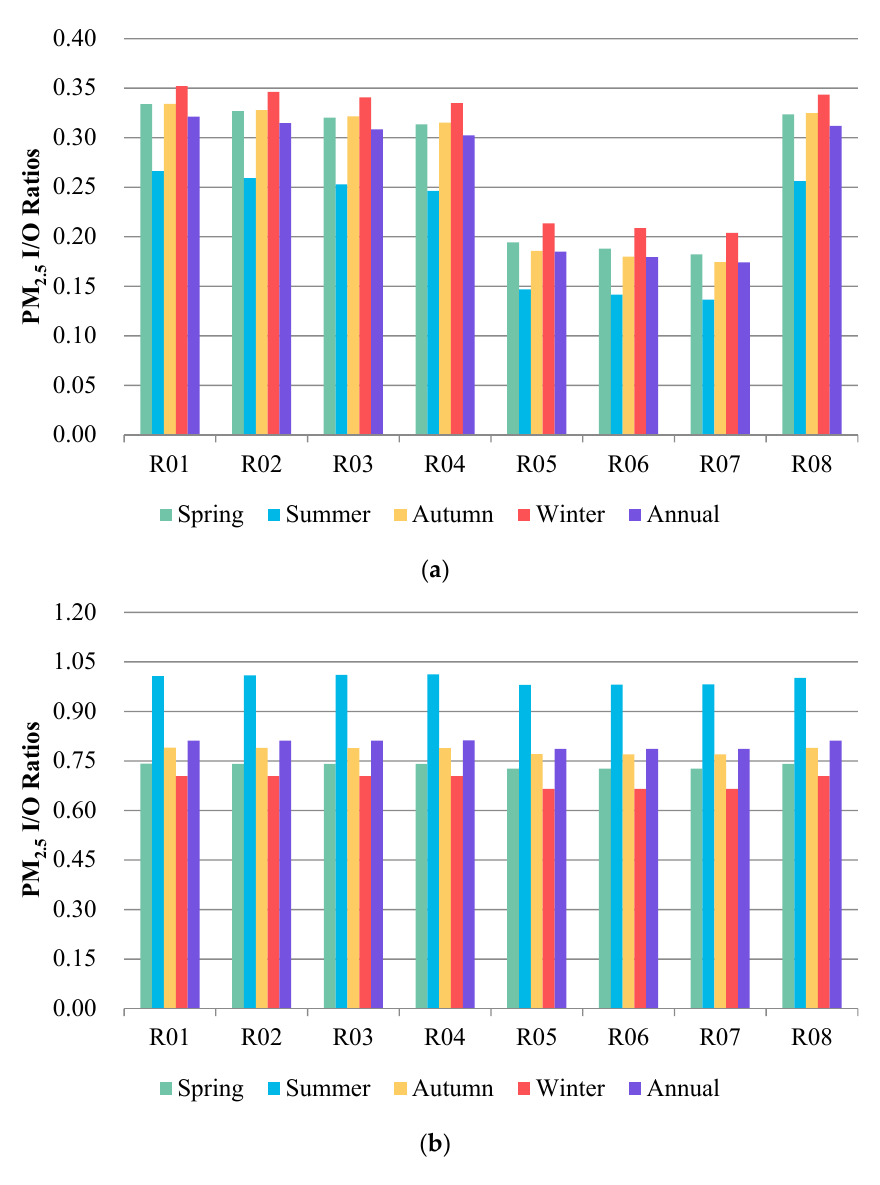
Figure 5. Average seasonal PM 2.5 I/O ratios for different types of residences under Scenarios 1 ( a ) and Scenarios 2 ( b ).